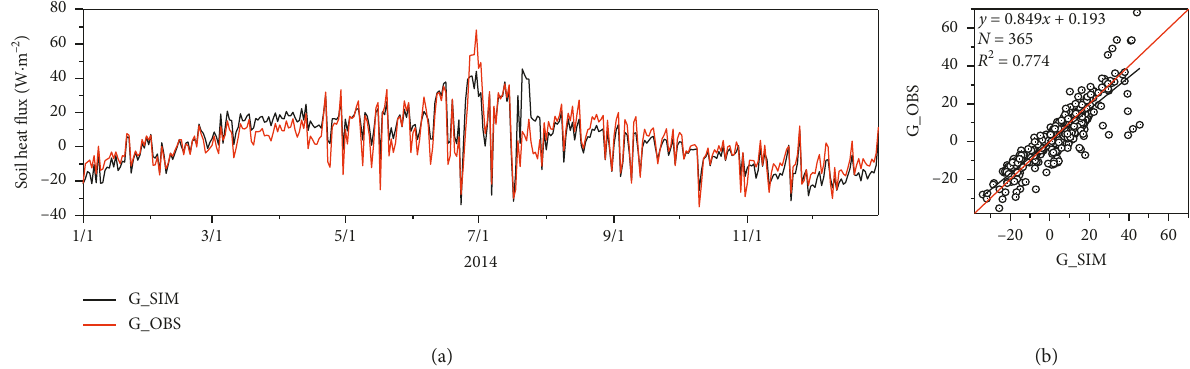
) at the Tazhong station in 0